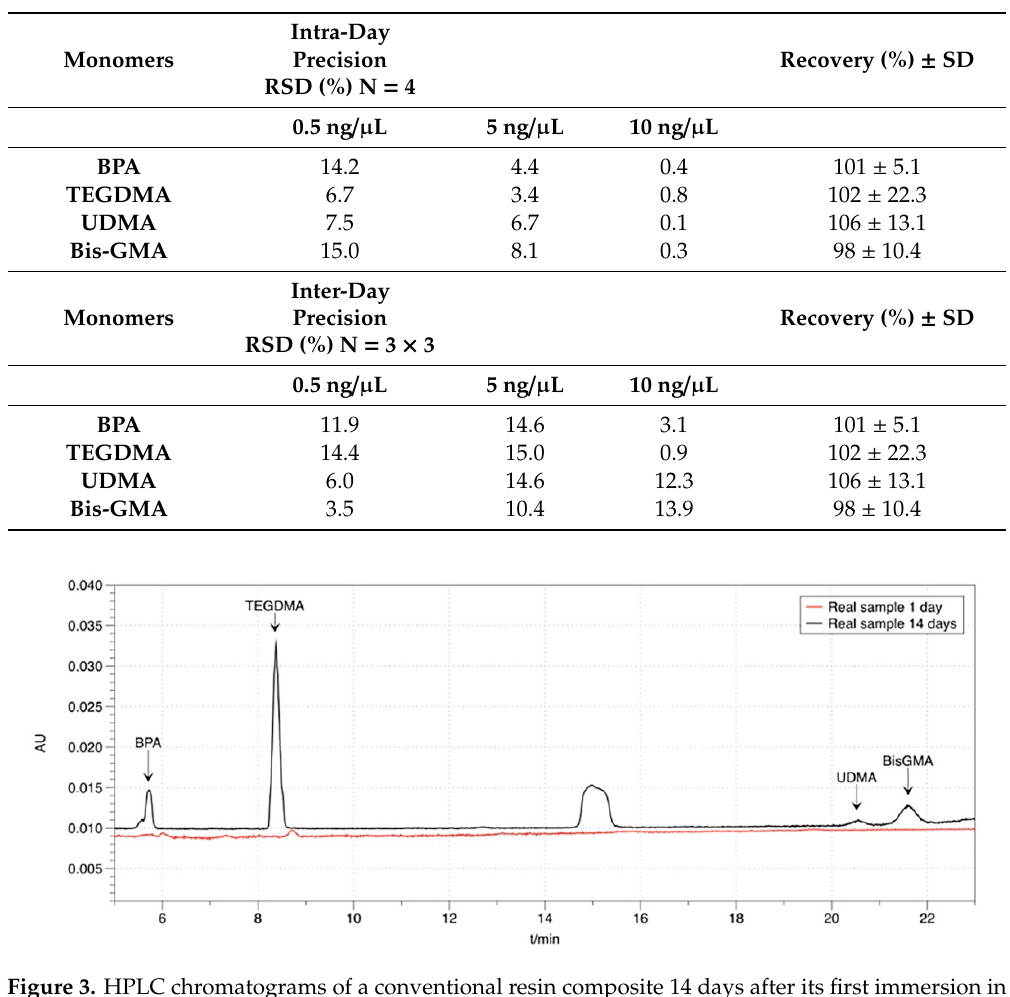
Figure 3. HPLC chromatograms of a conventional resin composite 14 days after its first immersion in artificial saliva (black) and a CAD / CAM composite, 1 day after its first immersion in artificial saliva (red) .